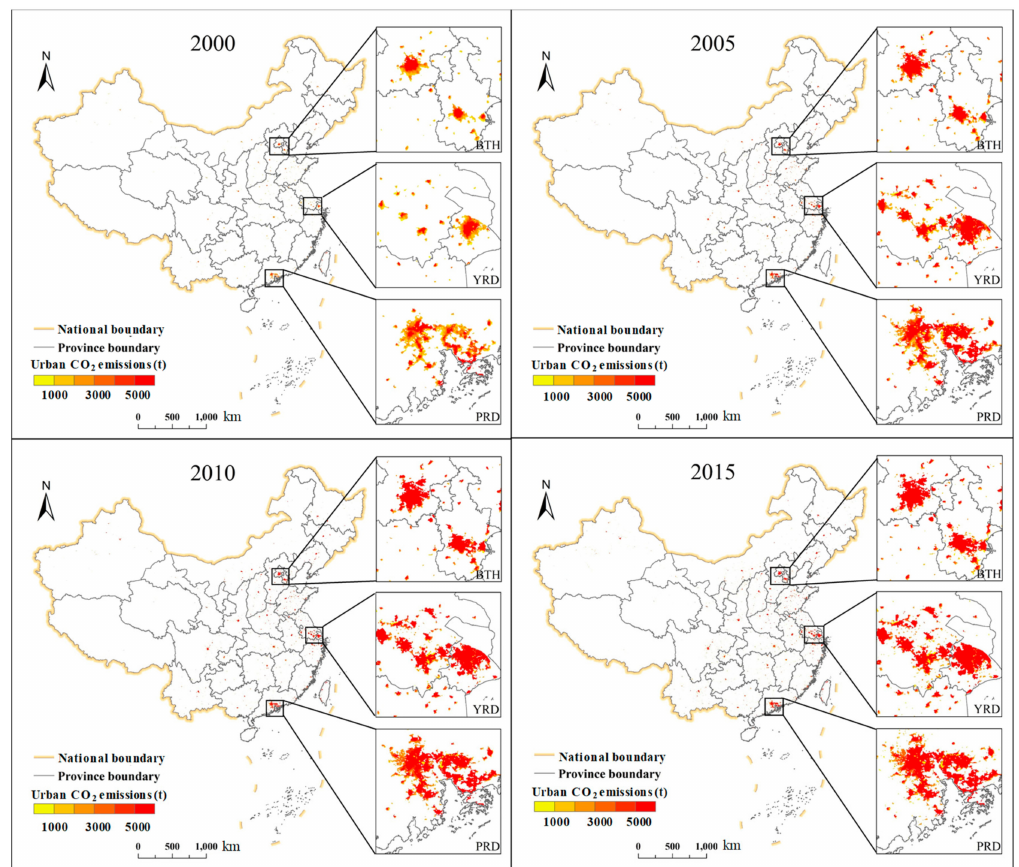
Figure 6. Urban CO 2 emissions in China from 2000 to 2015. Note: The three magnified urban agglomeration areas are BTH, YRD and PRD. BTH represents the Beijing-Tianjin-Hebei urban agglomeration; YRD represents the Yangtze River Delta urban agglomeration; and PRD represents the Pearl River Delta urban